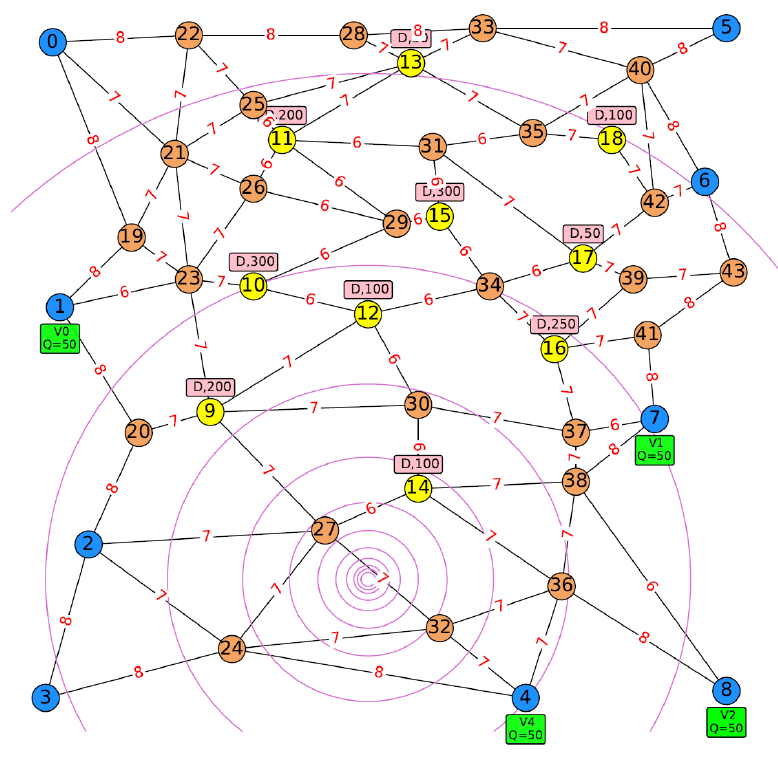
Figure A8. Road network for instance D9N25S10.